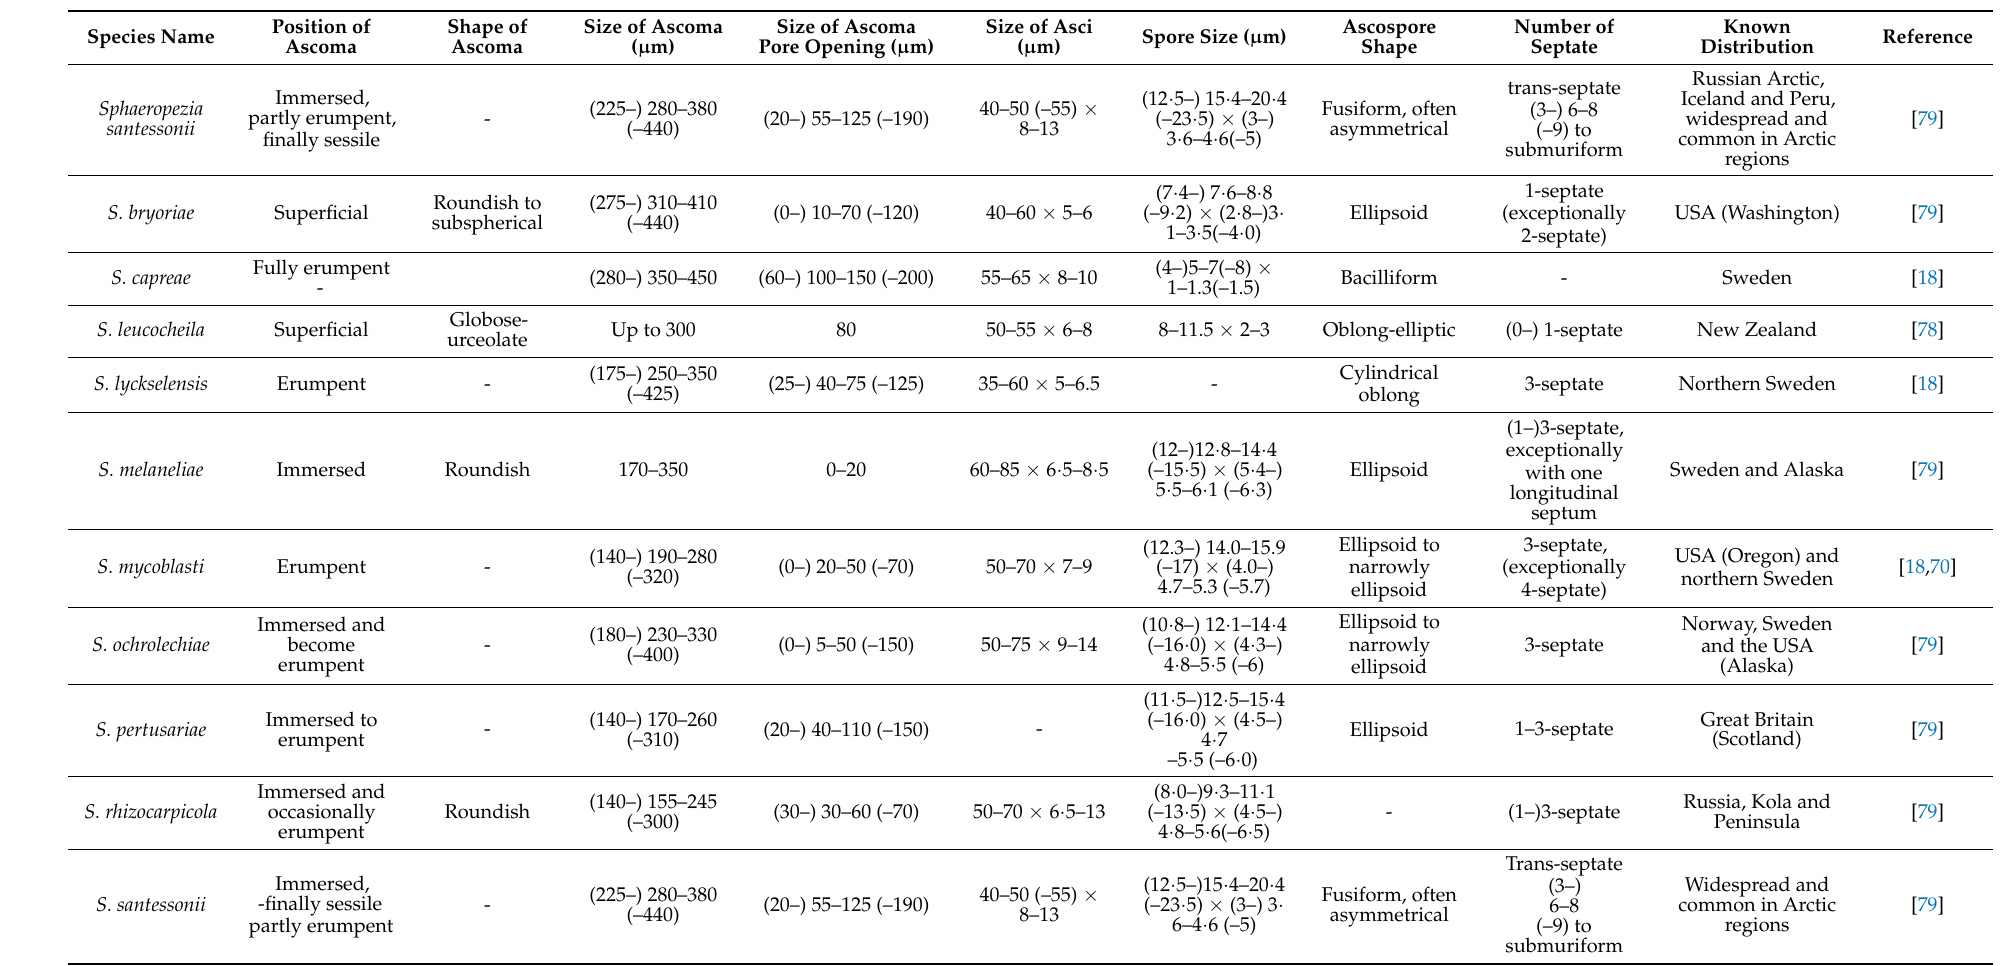
Table 2. Synopsis of recorded Sphaeropezia